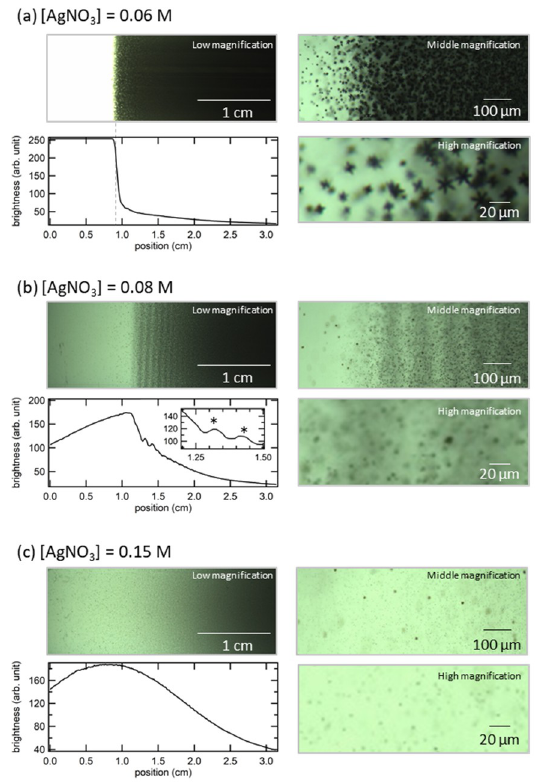
Figure 2. Microscopic images and brightness line profiles for three different experimental conditions. [NaCl] was fixed at 0.01 M, and [AgNO 3 ] was ( a ) 0.06 M, ( b ) 0.08 M, and ( c ) 0.15 M. Asterisks in ( b ) indicate the position of band.